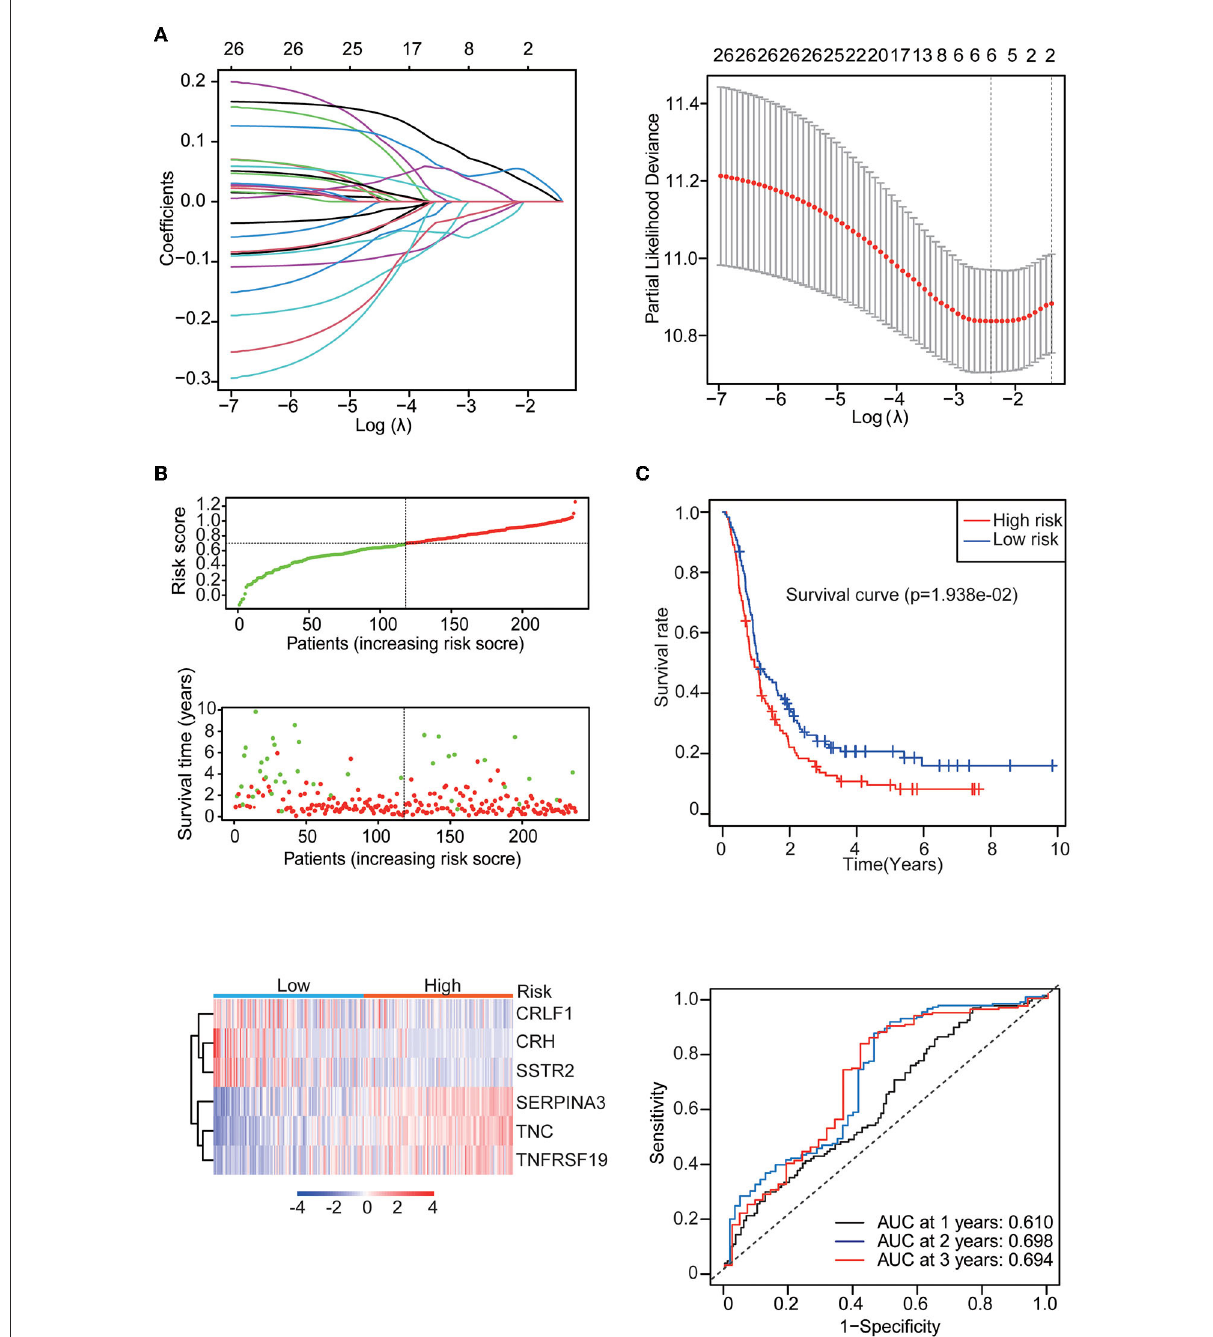
FIGURE3 Identification of the IRG prognostic signature. (A) Coefficients of the determined characteristics are shown by the lambda parameter. The partial probability deviance relative to log ( λ ) was calculated via the LASSO Cox regression approach. (B) Prognostic assessment of the gene signature in the CGGA mRNAseq_693 cohort. Top: The dotted line designates the median risk score and stratifies the patients into low-risk GBM and high-risk GBM groups. Middle: Survival status of the patients. Bottom: Heatmap showing the expression patterns of the prognostic genes in the low-risk GBM and high-risk GBM groups. (C) Kaplan–Meier survival analysis of patients stratified by the gene signature. Time-dependent ROC analysis of the gene signature.